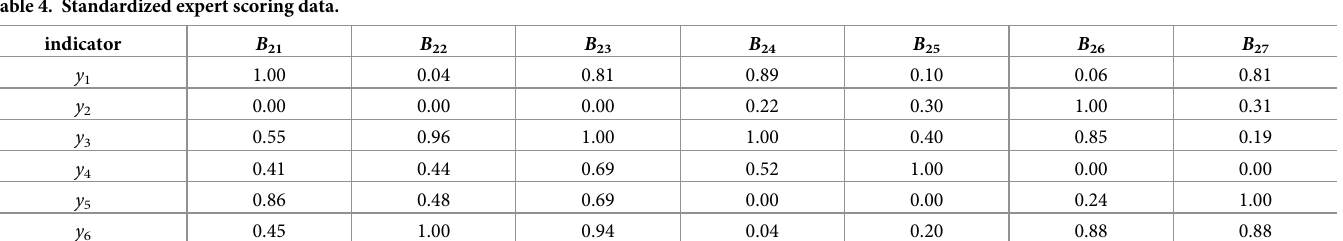
Table 4. Standardized expert scoring